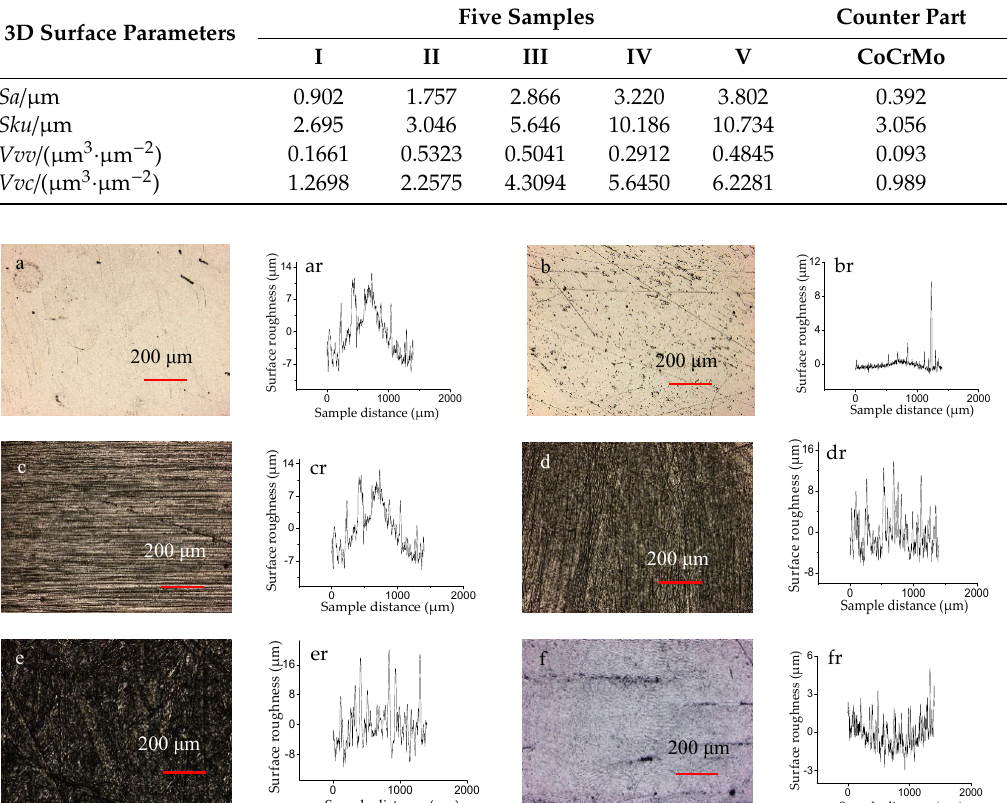
Table 2. The 3D surface parameters before testing.